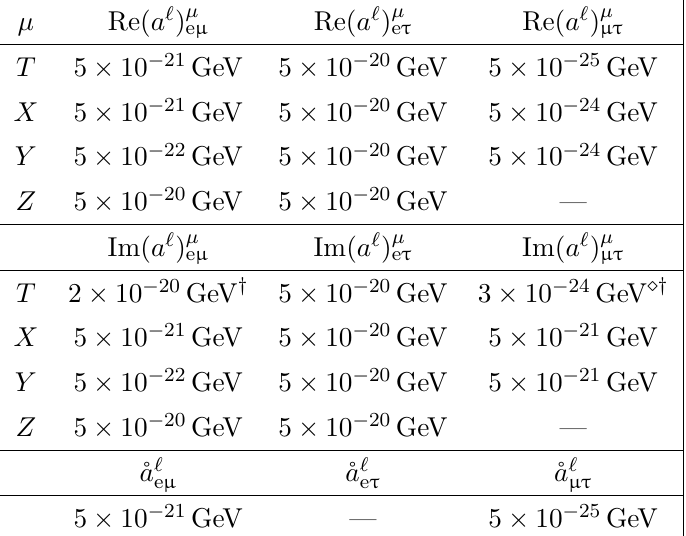
Table 1 . Potential sensitivities of flavour-off-diagonal dim-3 vector-valued coefficients ( a ‘ ) µ in AB the charged-lepton sector obtained from limits in the neutrino sector via SU(2) L invariance (see appendix A for calculational details). All sensitivities are two-sided unless those with the symbol (cid:5) that are upper ones. Here we assumed that only left-handed charged-lepton fields are modified, i.e., ( a R ) µ = 0 . Then the (unstated) sensitivities on ( b ‘ ) µ equal those on ( a ‘ ) µ . In the LR- AB AB AB symmetric case, the values for ( a ‘ ) µ must be multiplied by a factor of 2 while no bounds on ( b ‘ ) µ AB AB can be obtained. Whenever possible, the sensitivities were inferred from values listed in table S4 of ref. [22] and the symbol † indicates data used from table D29 of the same reference. All values are given in the standard Sun-centered inertial reference frame [22]. The index T stands for the time component and { X, Y, Z } for the spatial components. The notation ˚ a ‘ , etc. denotes isotropic AB parts of the coefficients (see section IV.B in ref. [29] for their